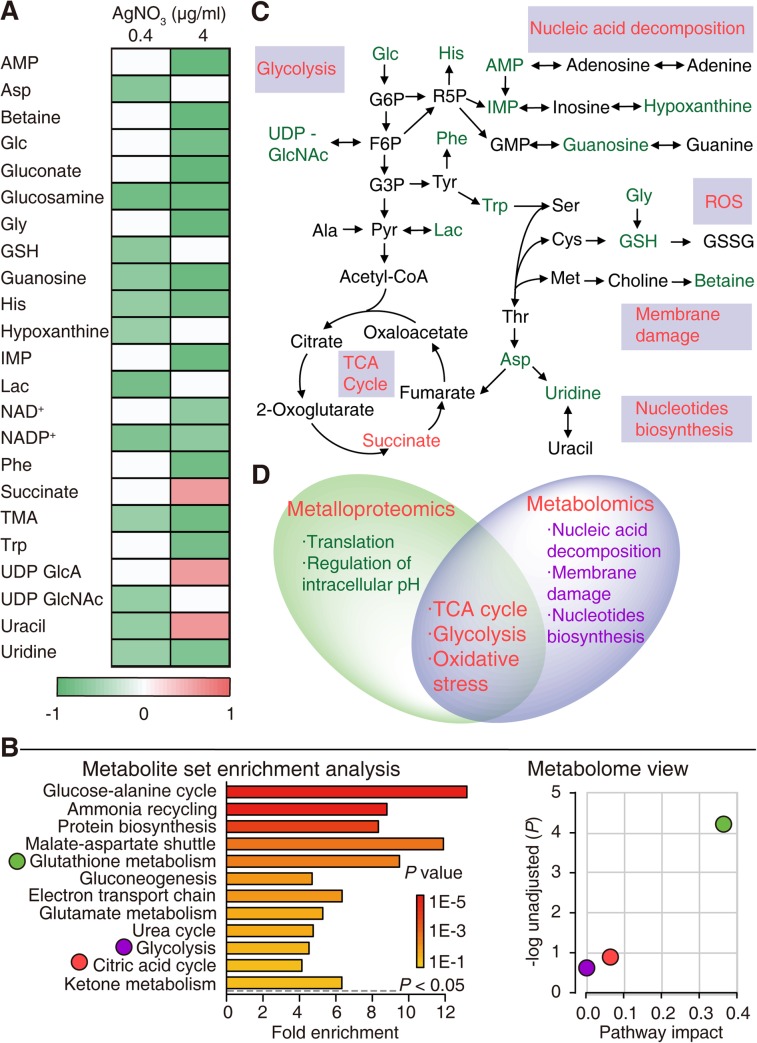
Depiction of metabolome changes in E. coli following Ag+ treatment.(A) Heat map of all changed metabolites in E. coli cells post to low (0.4 μg/ml) and high (4 μg/ml) concentrations of AgNO3. The metabolites colored in red and green represent significantly up or down alterations in the AgNO3-treated groups compared with control groups respectively (n = 10, P < 0.05). (B) Analysis of metabolic pathways disrupted after Ag+ treatment. Summary plots for the MSEA (left) are ranked by Holm P value. Metabolome view (right) shows key nodes in metabolic pathways that have been significantly altered upon Ag+ treatment. (C) Schematic summary of the metabolic response in E. coli exposed to Ag+. (D) Comparison of the functional pathways enriched by Ag+-binding proteins and altered metabolites induced by Ag+. Numerical values that underlie the graphs are shown in S1 Data. Ag, silver; AgNO3, silver nitrate; AMP, adenosine monophosphate; Asp, aspartate; Glc, glucose; Gly, glycine; GSH, reduced glutathione; His, histidine; IMP, inosine-5'-monophosphate; Lac, lactate; MSEA, Metabolite Set Enrichment Analysis; NAD+, nicotinamide adenine dinucleotide; NADP+, nicotinamide adenine dinucleotide phosphate; Phe, phenylalanine; TMA, trimethylamine; Trp, tryptophan; UDP GlcA, UDP glucoronate; UDP-GlcNAc, UDP-N-acetyl glucosamine.